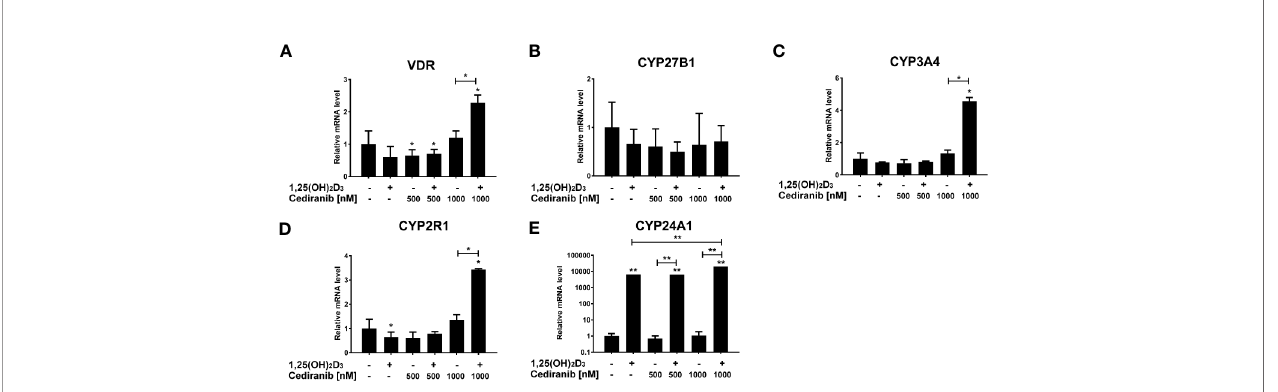
FIGURE 9 | The effect of 24-h preincubation with 1,25(OH) 2 D 3 at 100 nM concentration on VDR (A) , CYP27B1 (B) , CYP3A4 (C) , CYP2R1 (D) , and CYP24A1 (E) gene expression in A375 melanoma cells treated subsequently for 24 h with cediranib at 500 or 1,000 nM concentration. mRNA levels were measured by qPCR. The results are representative of three experiments carried out in duplicate. * p < 0.05 and ** p < 0.01 vs. untreated control or between the two groups indicated by the bracket.